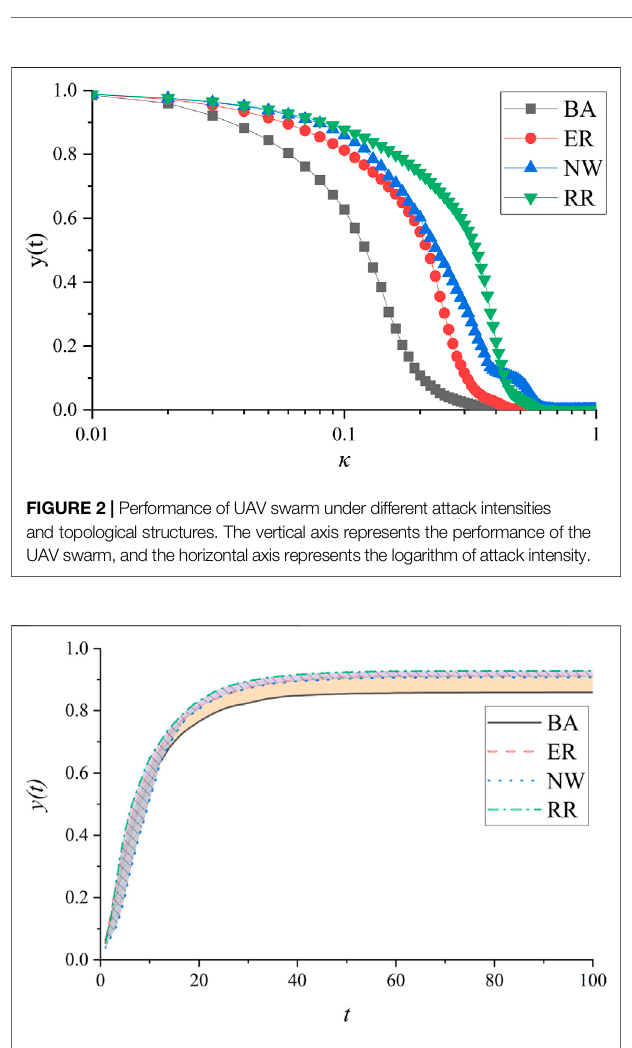
FIGURE 3 | Recovery process of UAV swarm performance under different topological structures. The ordinate is the performance of the UAV swarm,andtheabscissaisdiscretetimeT.Therepairprobabilityis0.1,thatis, ateverydiscretetimet,theprobabilityofdamagednodesbeingrepaired follows a uniform distribution in the interval of (0, 1).